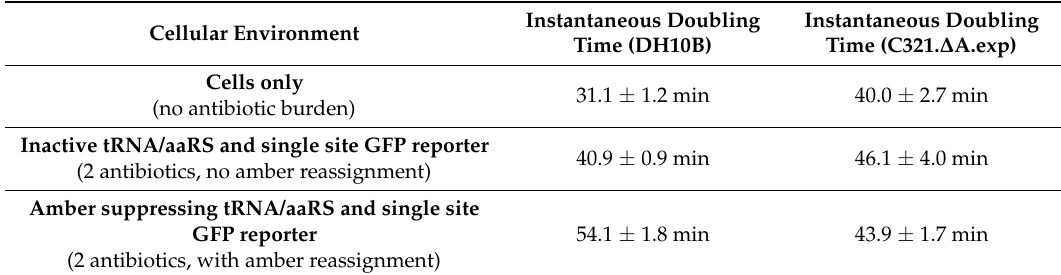
Table 4. Instantaneous doubling times for amber stop codon suppressing